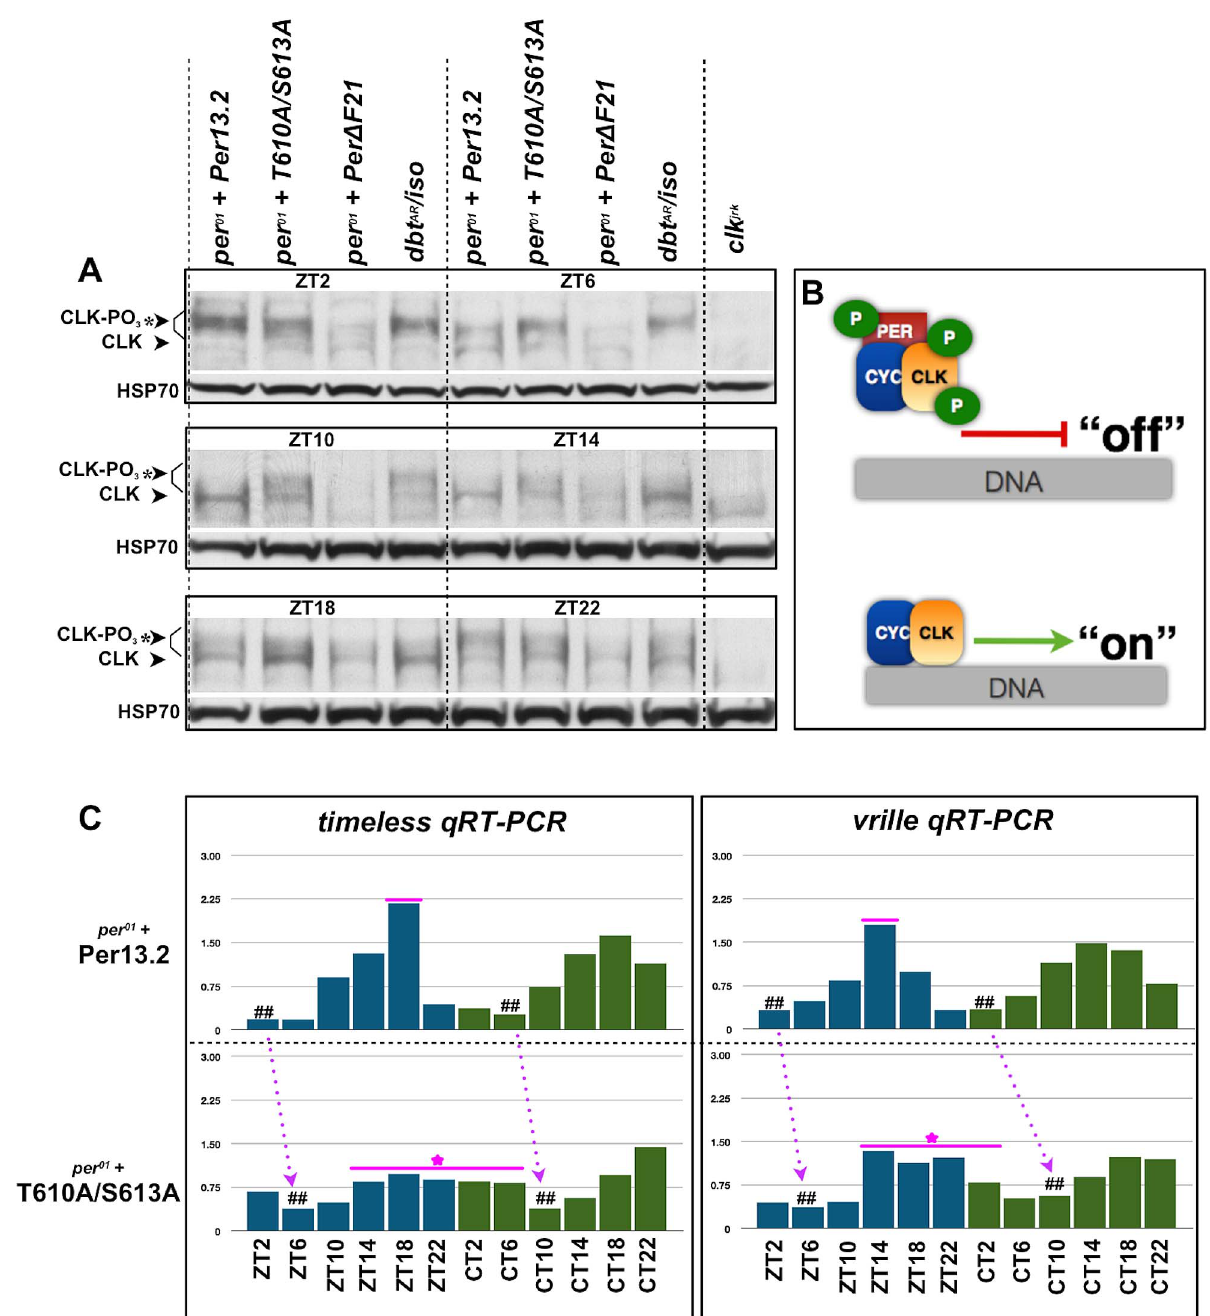
Figure 7. The T610 and S613 mutations affect CLK phosphorylation and CLK-mediated transcriptional output. ( A ) Head extracts were prepared from an equal number of per 01 flies expressing a wild type per 13.2 or PER-T610A/S613 transgene at the indicated time points. As a control to demonstrate CLK hypophosphorylation and hyperphosphorylation at each time point, we also prepared head extracts from per 01 flies expressing a PER- D DBT (lacks DBT binding; line F21, a gift from Paul Hardin; [22]) or a catalytically compromised mutant form of DBT, dbt AR / + , respectively. At ZT2, CLK is exclusively hyperphosphorylated in both wild type and PER-T610A/S613A, consistent with low transcriptional output. By ZT6, CLK is partially de-phosphorylated in files expressing wild type PER, whereas CLK remains exclusively hyperphosphorylated in the double mutant. From ZT10–ZT14, CLK is exclusively hypophosphorylated in flies expressing the wild type transgene and becomes mostly hyperphosphorylated once again by ZT22. On the other hand, in double mutant flies, CLK is observed as a mixture of hypo- and hyperphosphorylated forms from ZT10–ZT22. ( B ) Diagram depicting the effects of CLK phosphorylation on transcriptional output. ( C ) Quantitative real-time RT-PCR was used to measure tim and vri mRNA levels in heads from flies expressing wild type per 13.2 or PER-T610A/S613A at the indicated ZT and CT time points. Dashed arrows designate a shift in daily troughs of CLK-mediated output (number signs) between wild type and mutant flies, consistent with the long period phenotype. Magenta line + star represent delayed transcriptional repression and blunted transcriptional response in the double mutant. Data are representative of multiple independent experiments.